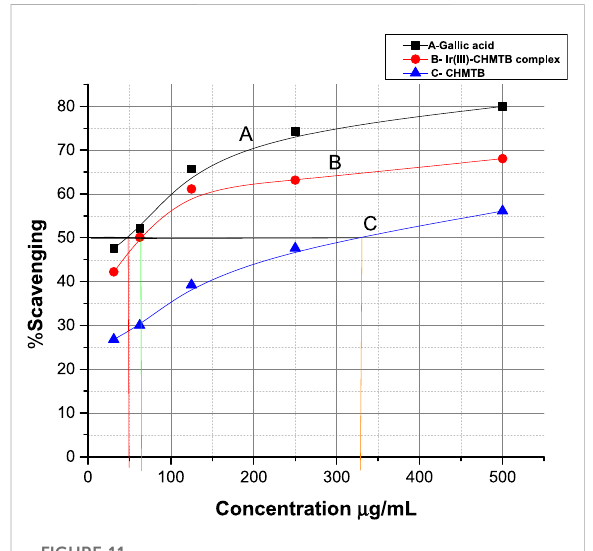
FIGURE 11 Percent radical scavenging activity of (A) gallic acid, (B) Ir (III)- CHMTB complex, and (C ) CHMTB.